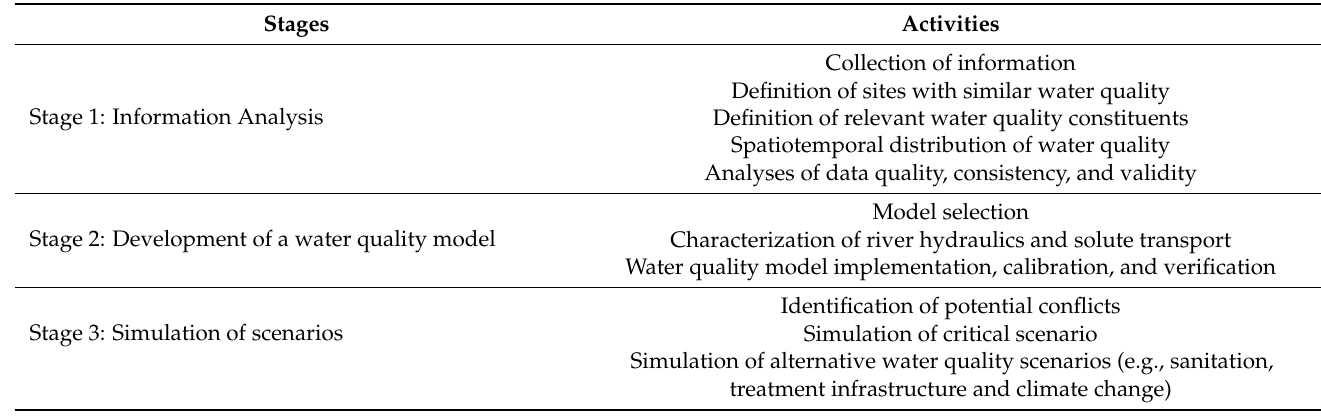
Table 1. Framework of stages and